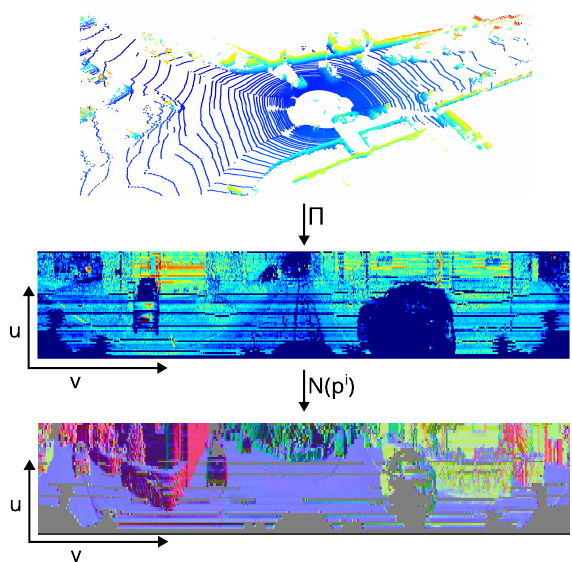
Figure 1. Entire point cloud encoding pipeline starting with, top) input point cloud, middle) discretized point cloud as an image using spherical projection with channels C = ( x, y, z ) , bottom) normal image with channels C = ( n x , n y , n z )